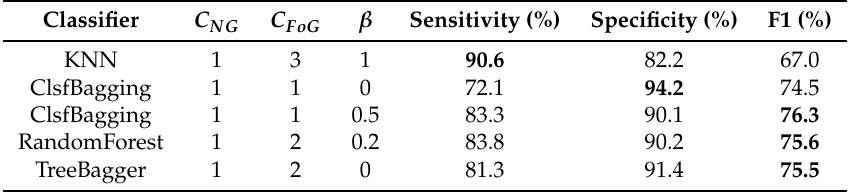
Table 6. Best performing classifiers in patient independent models (Results show average performance of all seven participants). The bold values show the highest performance among all the classifiers.